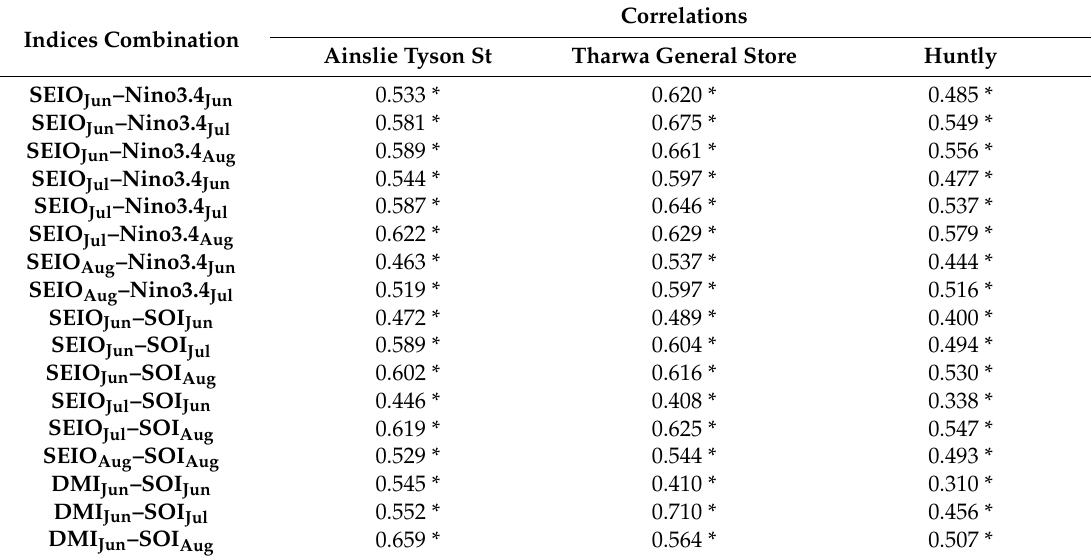
Table 4. Pearson correlations of the developed models for the selected rainfall